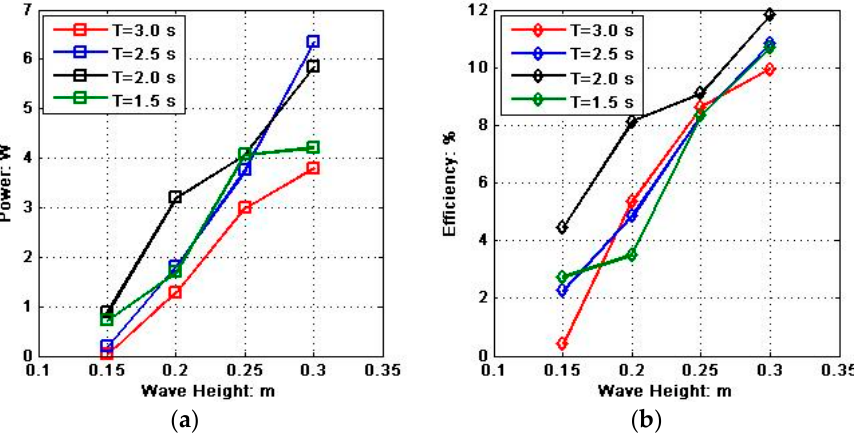
Figure 17. Generation performance of the ACWEC with different wave heights, M 1 = 20.11 kg: ( a ) power curve; ( b ) efficiency curve.